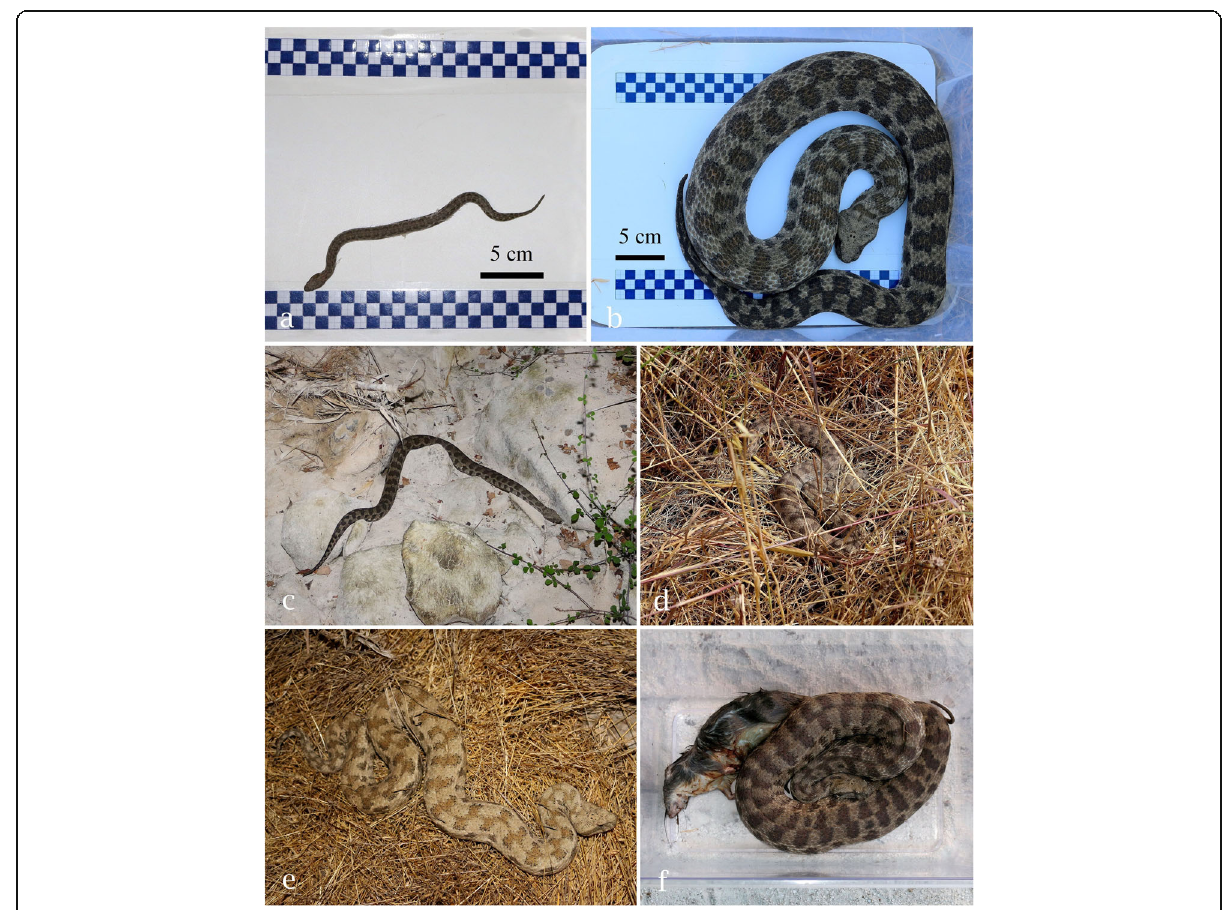
Fig. 2 a Dorsal view of a neonate blunt-nosed viper (SVL: 20.5cm, TaL: 3cm, weight: 10g) with a 5cm scale (11 September 2015). The skin is partially shed. b Dorsal view of an adult male blunt-nosed viper (SVL: 116.5cm, TaL: 14.5cm, weight: 1441g) with a 5cm scale. c The individual from 2b in a periodically dry streambed where it was found in ambush position on 6 September 2015, 22:05PM. d Young adult female blunt-nosed viper (SVL: 65.5 cm, TaL: 9cm, weight: 279g) basking well-camouflaged at the edge of cropland after rainfall (6 May 2014, 15:45PM). e Adult male blunt-nosed viper from Akamas Peninsula (SVL: 92.5cm, TaL: 12.5cm, weight: 749g), found in maquis and garrigue shrubland (28 September 2017, 20:45PM). f Adult female blunt-nosed viper (SVL: 86.5cm, TaL: 11.5cm, weight: 835g) with a regurgitated brown rat ( Rattus norvegicus ) of 270g. Found moving along a stream bank (Fig. 3a). Photos: D.